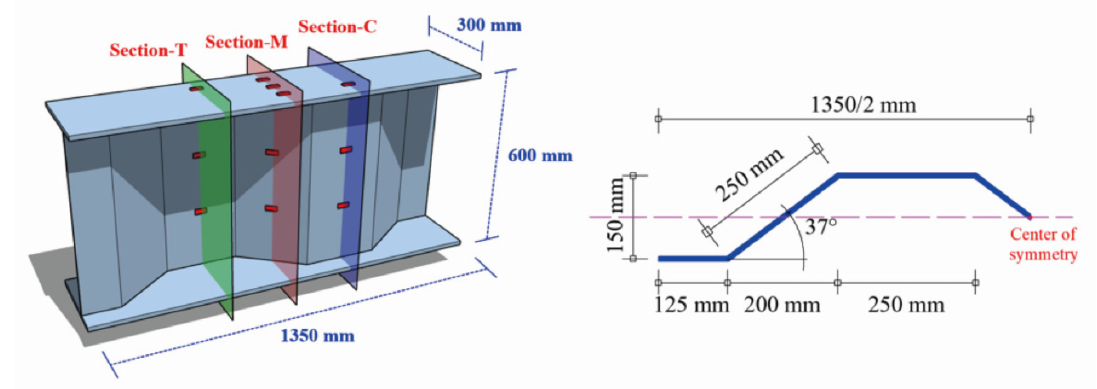
Figure 2. The detailed dimensions of the steel beam with corrugated